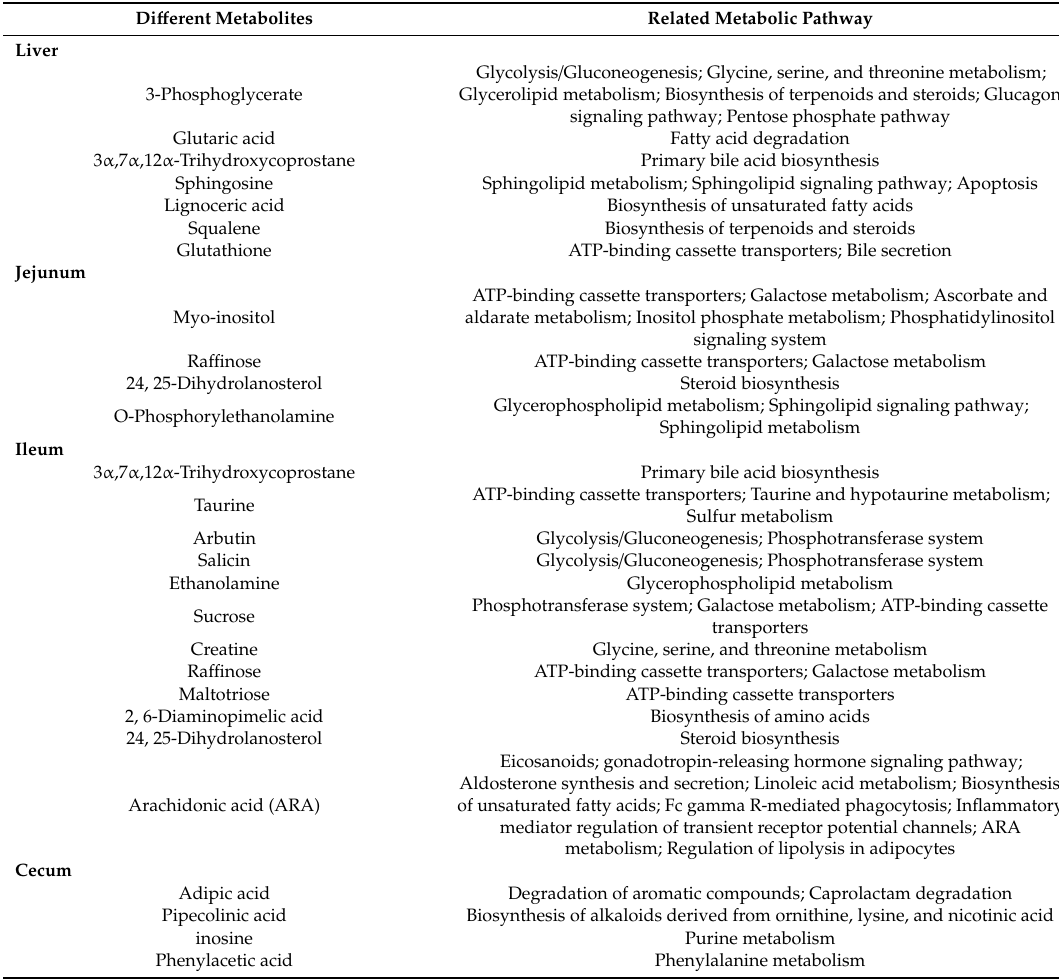
Table 3. Metabolic pathways identified with the di ff erent metabolites in the liver and intestinal contents between the control and overfed geese on the 12th day of